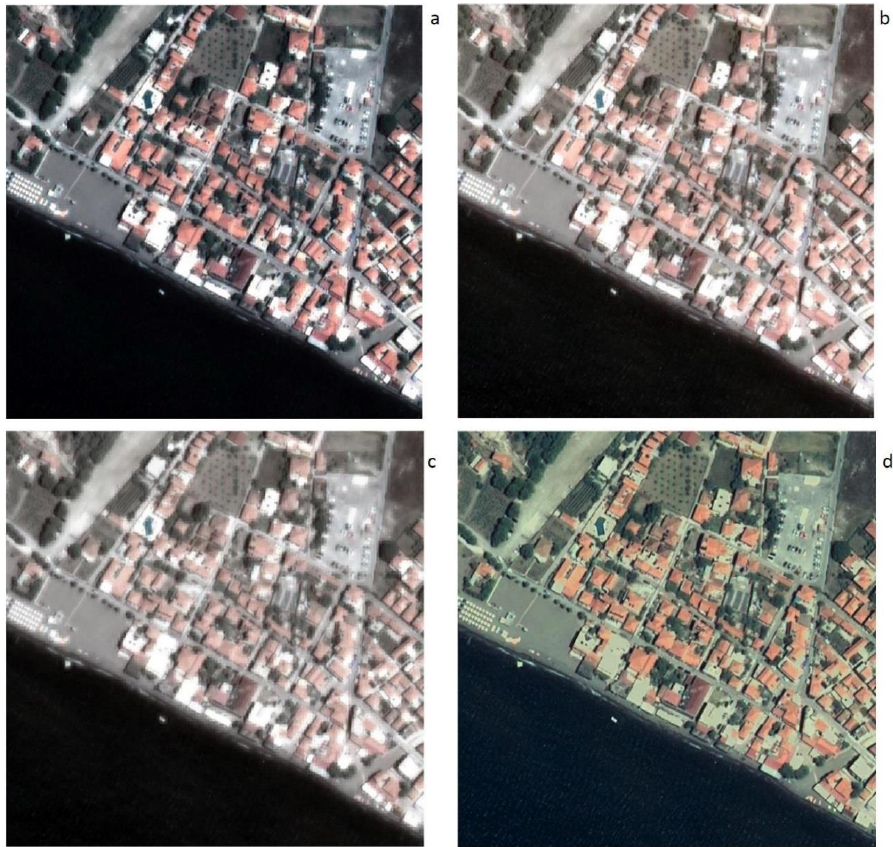
Figure 2. The image of the same region in Figure 1, after being processed by pan-sharpening tech- niques: ( a ) multiplicative method, ( b ) simple mean method, ( c ) IHS, and ( d ) Brovey transformation.